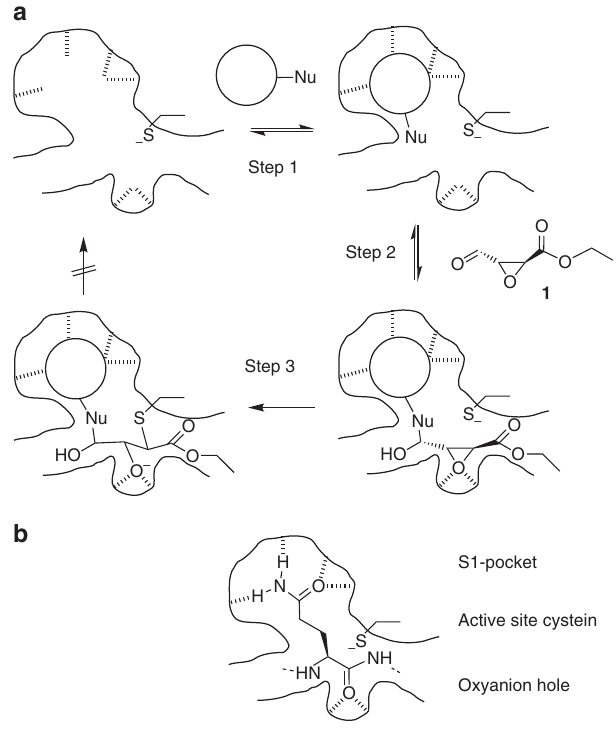
Figure 1 | Concept of the fragment-warhead activation assay. ( a ) Protein- templated, covalent assembly of an irreversible inhibitor of a cysteine protease: reversible binding of a nucleophilic fragment (Nu ¼ nucleophile) to the S1-site (step 1) positions the bis-electrophilic warhead 1 in a templated dynamic reaction at the active site of the protein (step 2), leading to irreversible inhibition of the protein (step 3). In the case that Nu is an amine nucleophile (Nu ¼ NHR), an imine intermediate instead of the depicted hemiaminal may be formed. ( b ) The active site of an enterovirus 3C protease with a bound peptide substrate containing a glutamine residue (Gln, Q) in P1 position occupying the S1 pocket of the